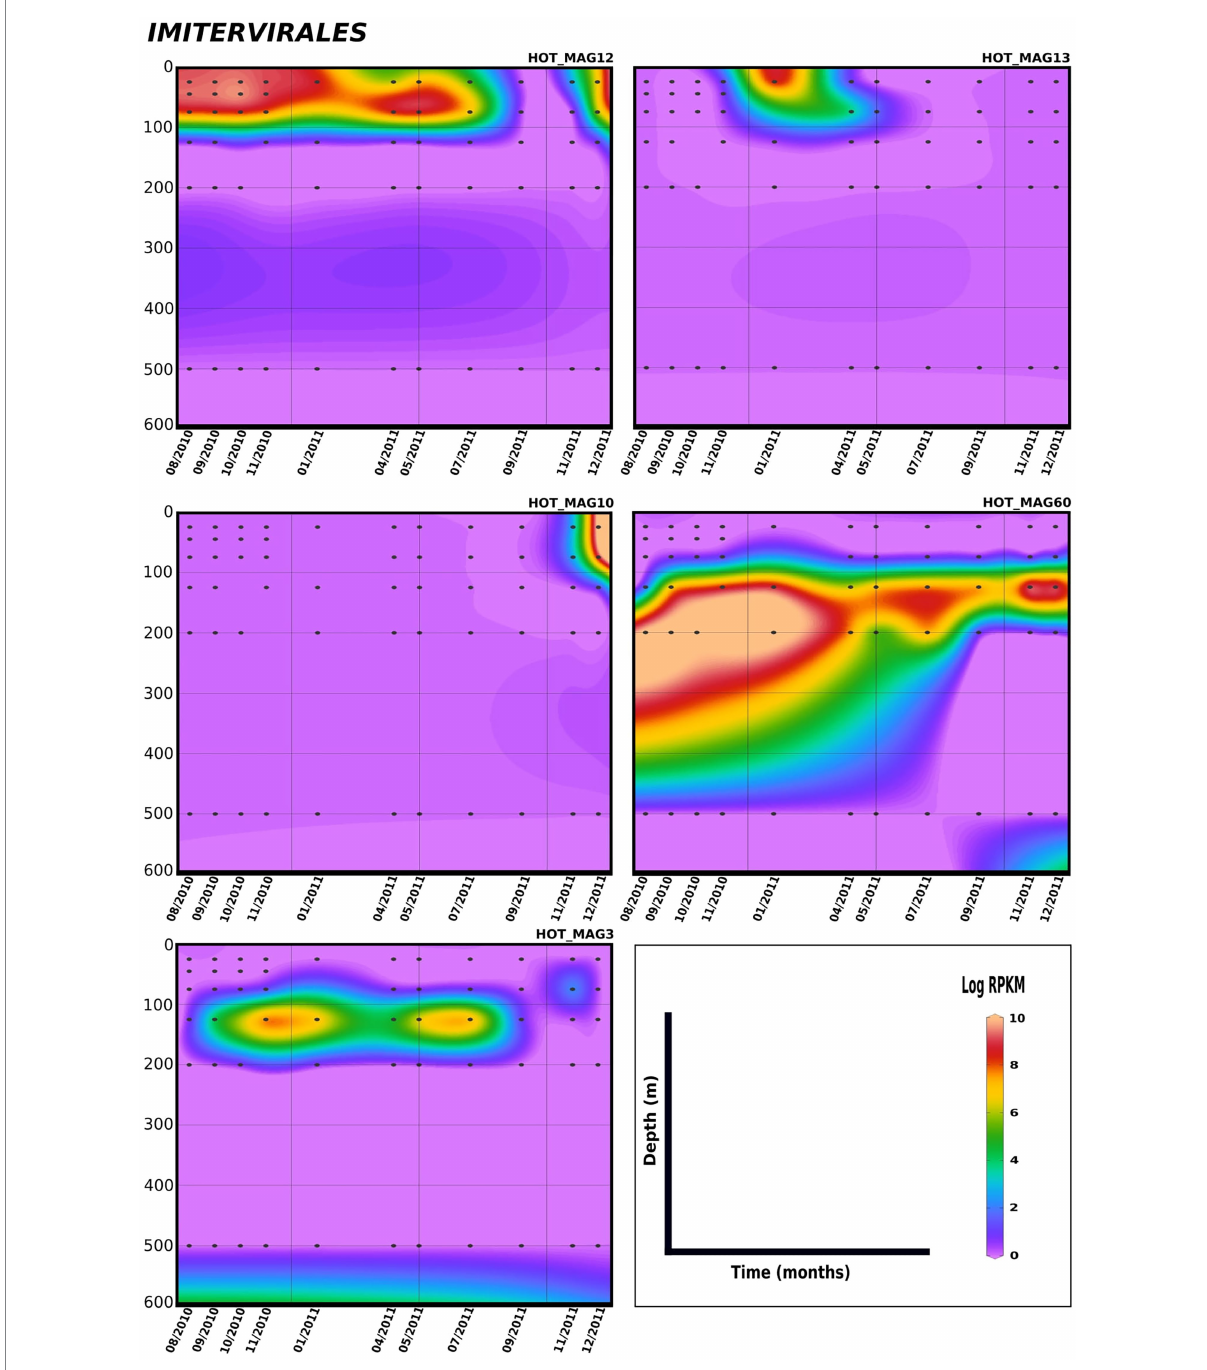
FIGURE 5 Distribution of 11 MAGs in the order Imitervirales in a 1.5-year sampling from St. ALOHA. Time series plots were drawn based on the results from mapping Hawaiian Ocean Time series metagenome dataset onto the 11 MAGs (see Materials and methods for details). The total abundance of the MAGs was calculated based on RPKM. Y-axis and x-axis represent depths(m) and latitudes, respectively and the colorful bar refers to the log of total abundance (RPKM) for each of the MAGs (high abundance = red and low abundance = purple). Only the distribution of the MAGs between 0 and 600 m were shown in the